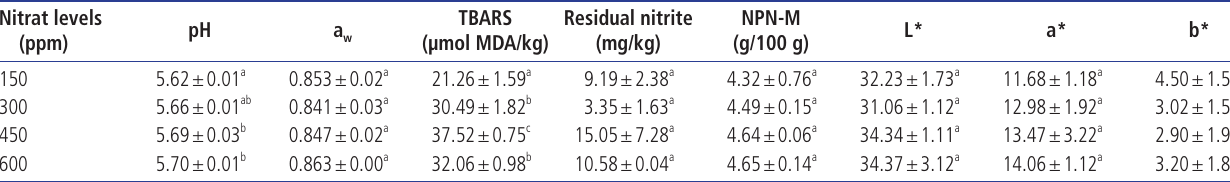
Table 2. Overall effect of nitrate level on physico-chemical properties of pastırma (values are means±SD) Nitrat levels